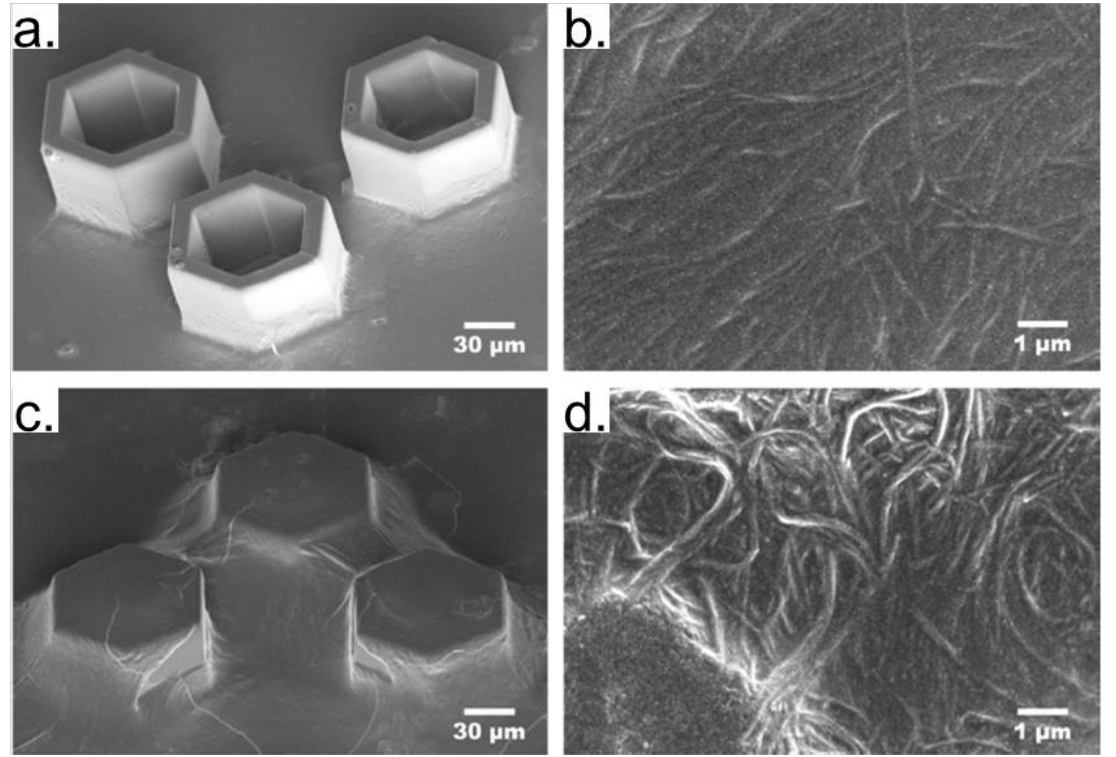
Figure 19. Bacterial cellulose (BC) grown on polymeric materials. ( a ) BC film formed after 6 h of bacteria incubation and ( b ) SEM image of the BC network grown in these structures. ( c ) BC film formed after 24 h of bacteria incubation and ( d ) SEM image of the BC network grown in these structures. Reproduced with permission [156]. Licensed under a Creative Commons Attribution 4.0 International